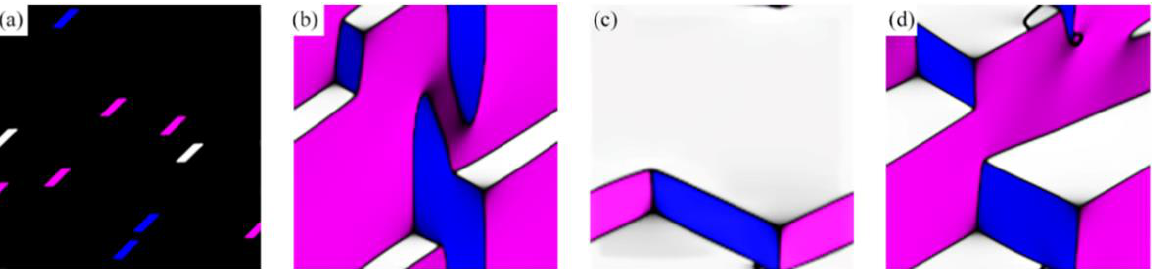
Figure 2. Comparison of variant morphology for different loading modes. ( a ) Random distribution of nucleation sites, ( b ) the final steady state for uniaxial tension, ( c ) the final steady state for uniaxial compression, and ( d ) the final steady state for shearing.